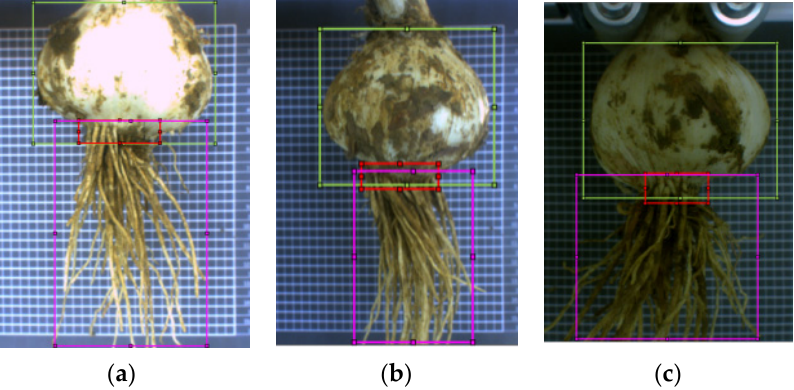
Figure 7. Comparison chart of different levels of object brightness: ( a ) high, ( b ) medium, and ( c )